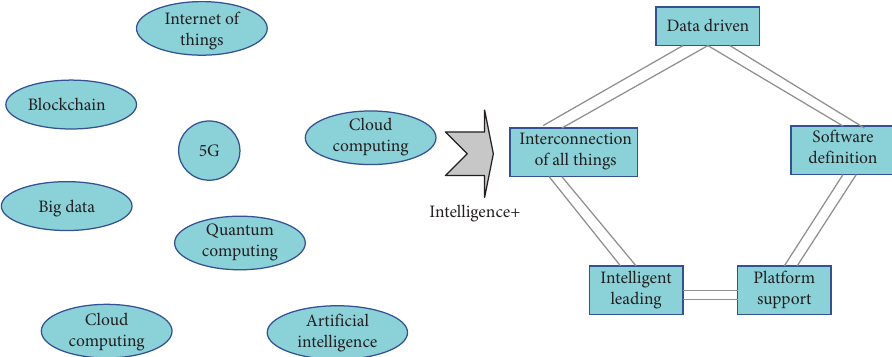
Figure 2: Concept map of DTs